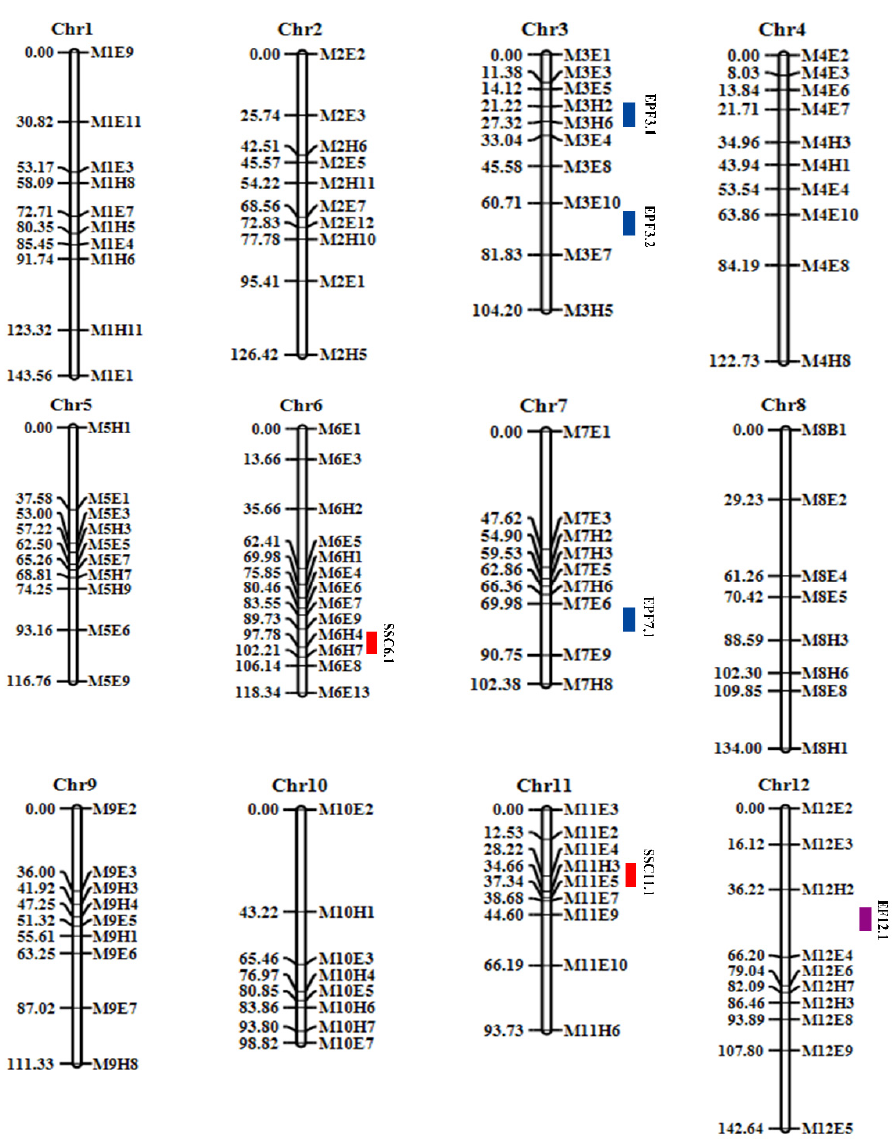
Figure 5. Based on the genotyping of 116 SNP-CAPS markers in the F 2 population, the genetic map